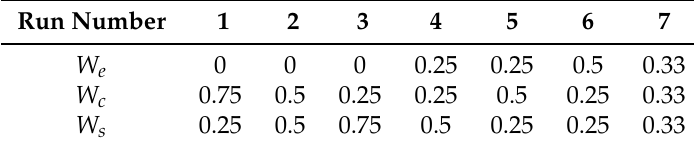
Table 2. Runs with different weight